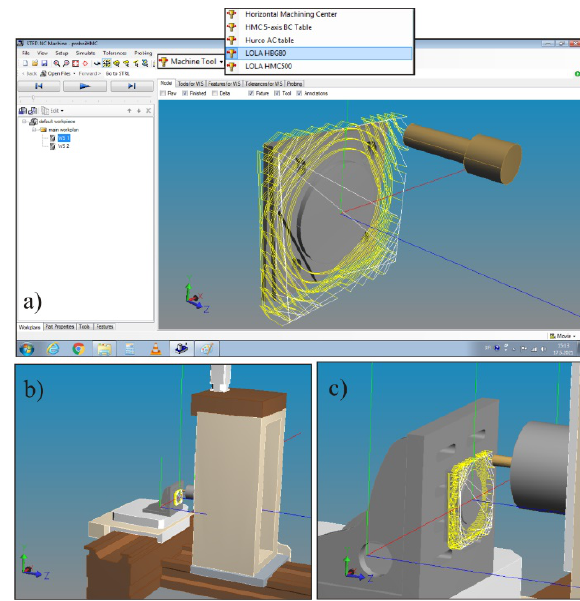
Figure 10. Configured LOLA HBG80 virtual machine tool in STEP-NC machine